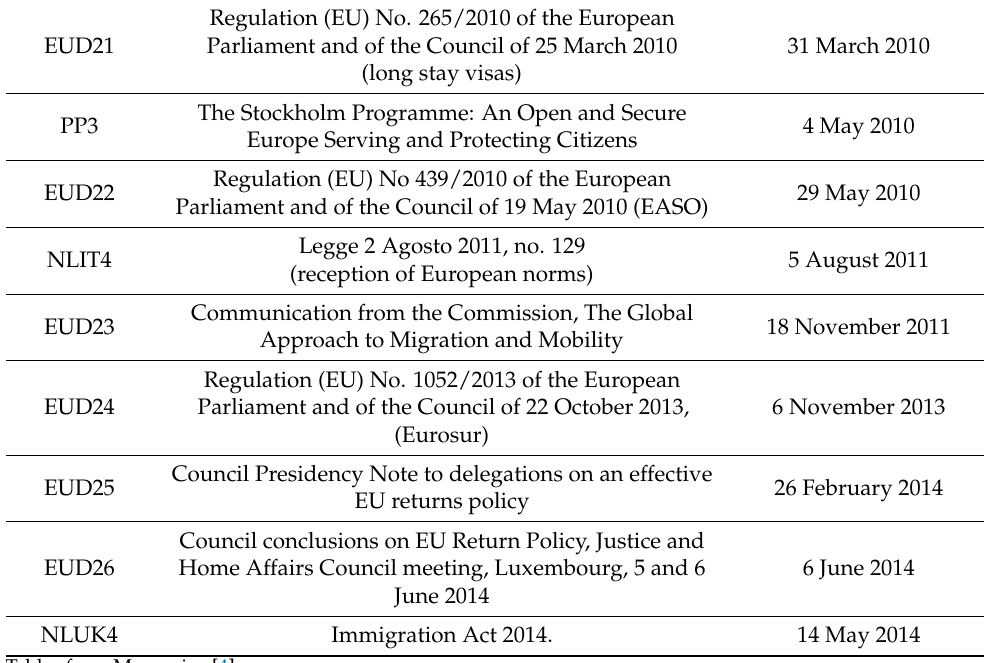
Table 4. Empirical materials, part 4